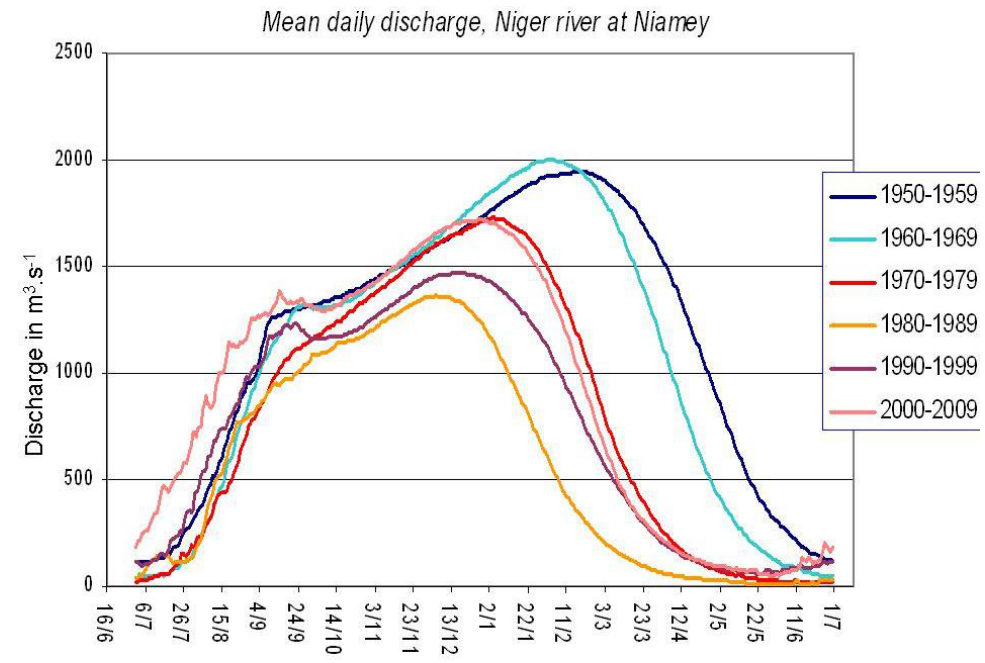
Figure 9. Average hydrographs of the Niger River by decades at the Niamey